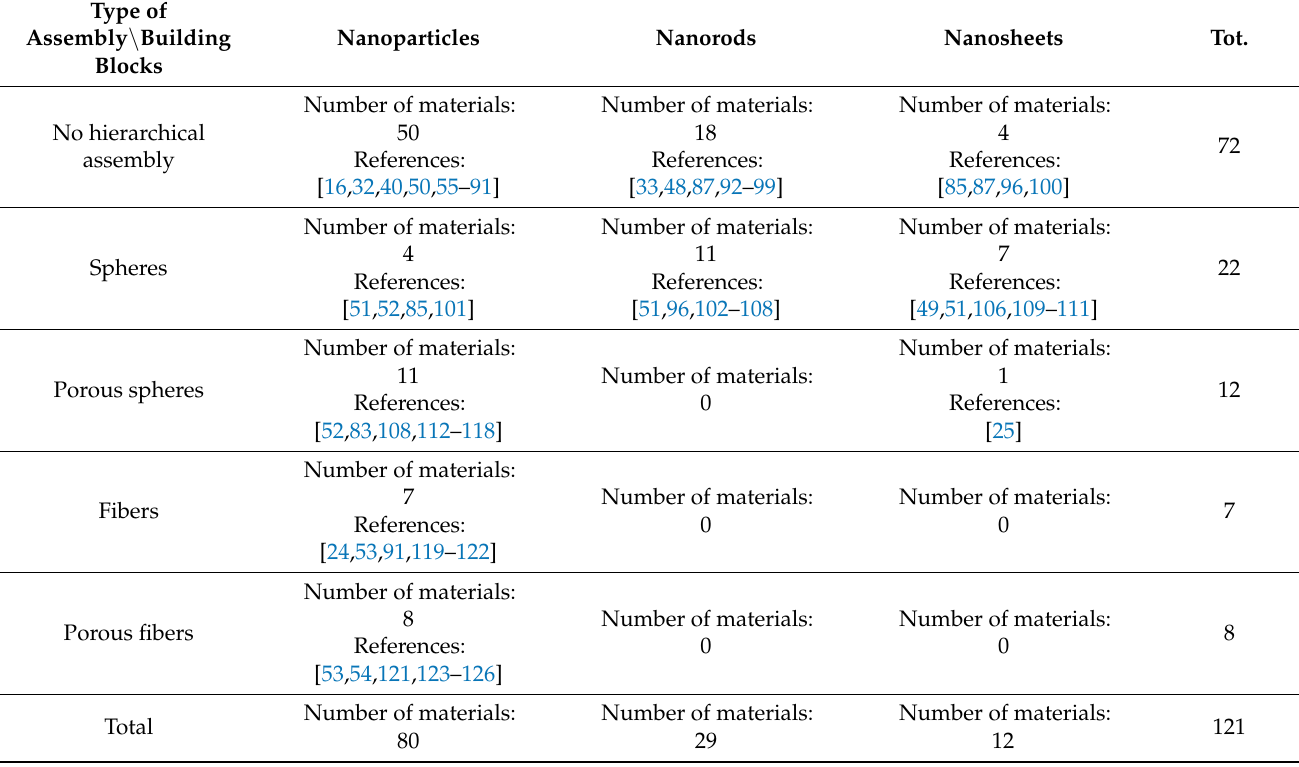
Table 1. Number of different materials (elementary building blocks and their eventual hierarchical organization) whose experimental responses to ethanol have been used for the statistical analysis reported in Section 4. For each morphological type, in addition to the number of materials, the related references are also